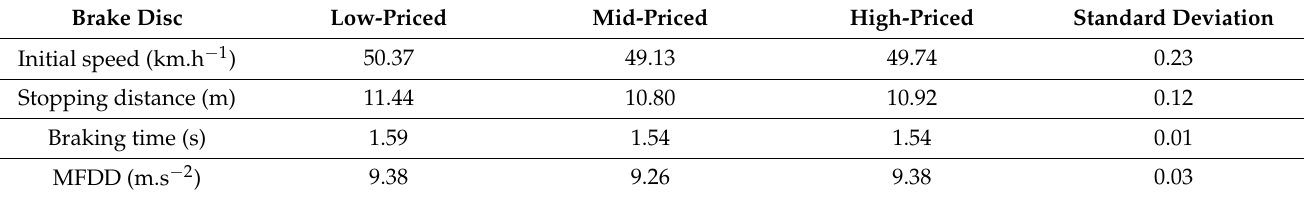
Table 8. Vehicle’s braking characteristics during the first